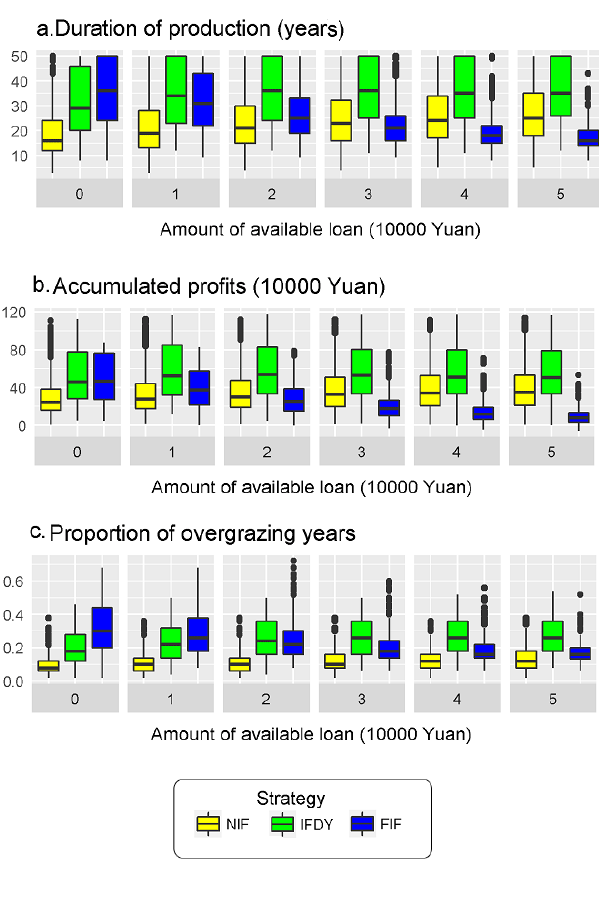
Fig. 7 . Impacts of loans on (a) household livelihood, (b) livestock production, and (c) ecosystem health with different forage import strategies for the baseline scenario. NIF - no import of fodder, IFDY - import of fodder only in disaster years, FIF - frequent import of fodder.